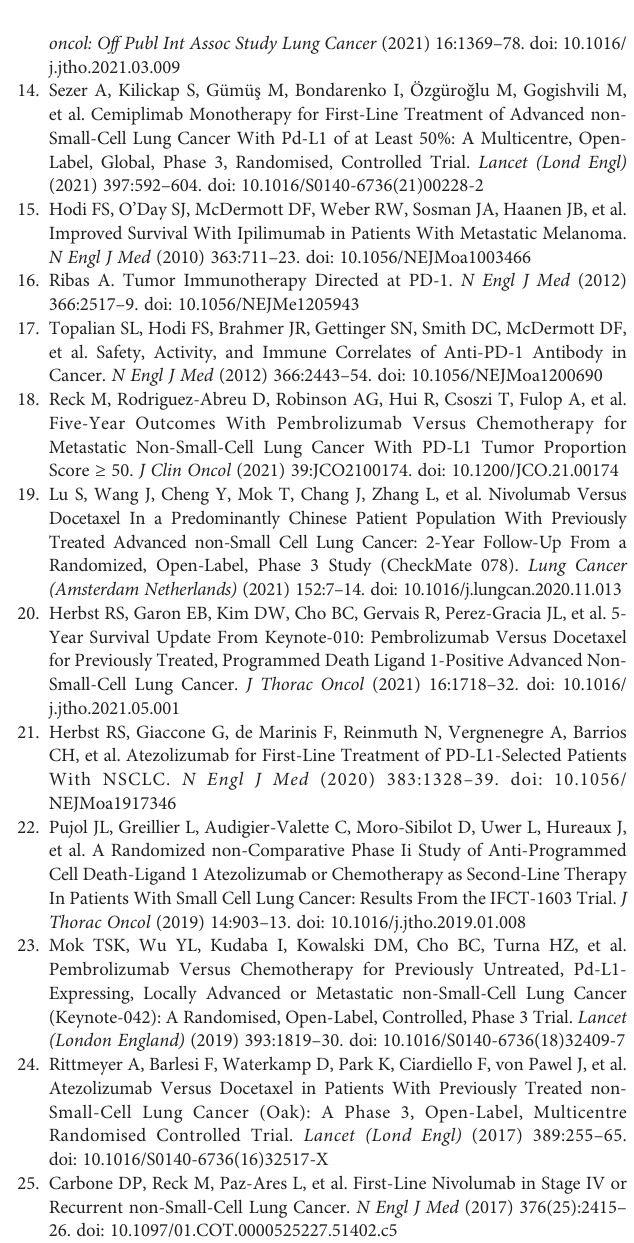
Supplementary Figure 1 | Risk of bias summary. Supplementary Figure 2 | Meta-analysis of OS. Supplementary Figure 3 | Meta-analysis of